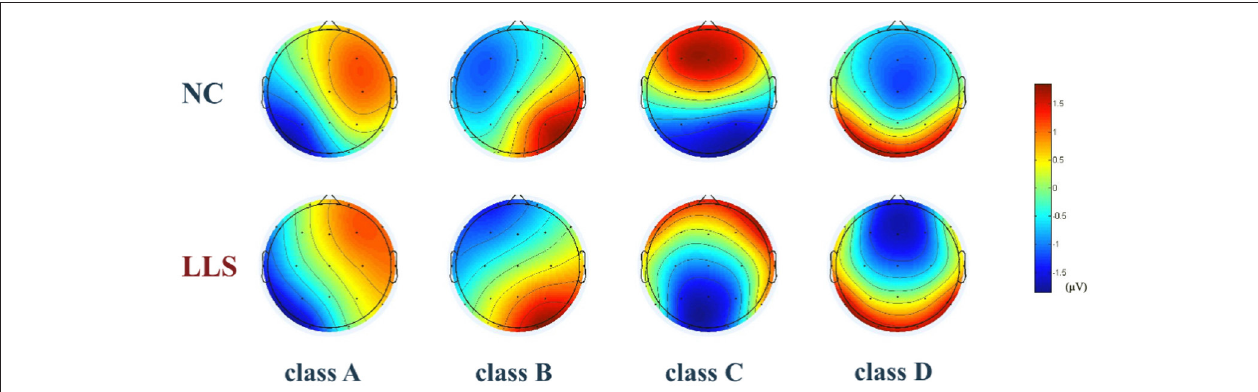
FIGURE 2 | The topographical maps of the four microstate classes (A–D) in the late-life schizophrenia group (LLS) and normal controls group (NCs). Classes A to D were labeled according to previous literature based on a well-established descriptive standard, whereby class A exhibits a right frontal to left occipital orientation, class B exhibits a left frontal to right occipital orientation, class C has a prefrontal to occipital orientation, and class D shows a frontocentral to occipital orientation. Color is used to represent electric potential. Red represents positive values, and blue represents negative values (the polarity in microstate can be inverted).